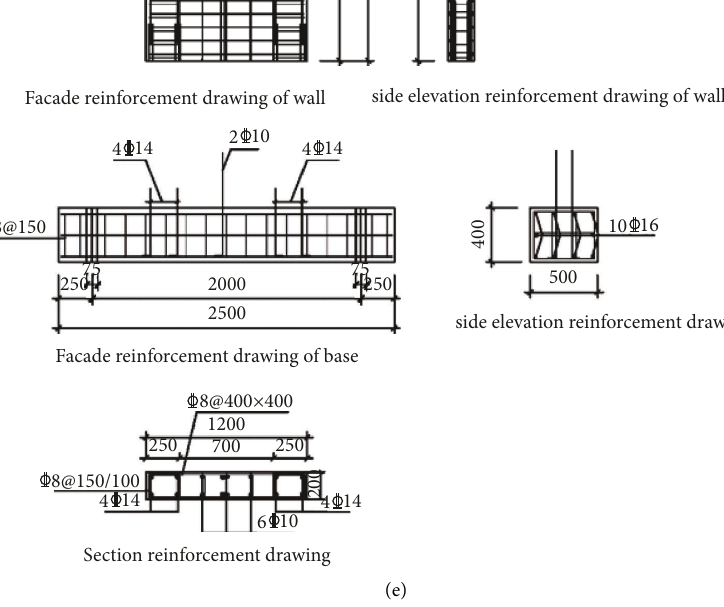
Figure 1: Specimen size and reinforcement drawing. (a) XJ. (b) YZ-1. (c) YZ-2. (d) YZ-3. (e) YZ-4.